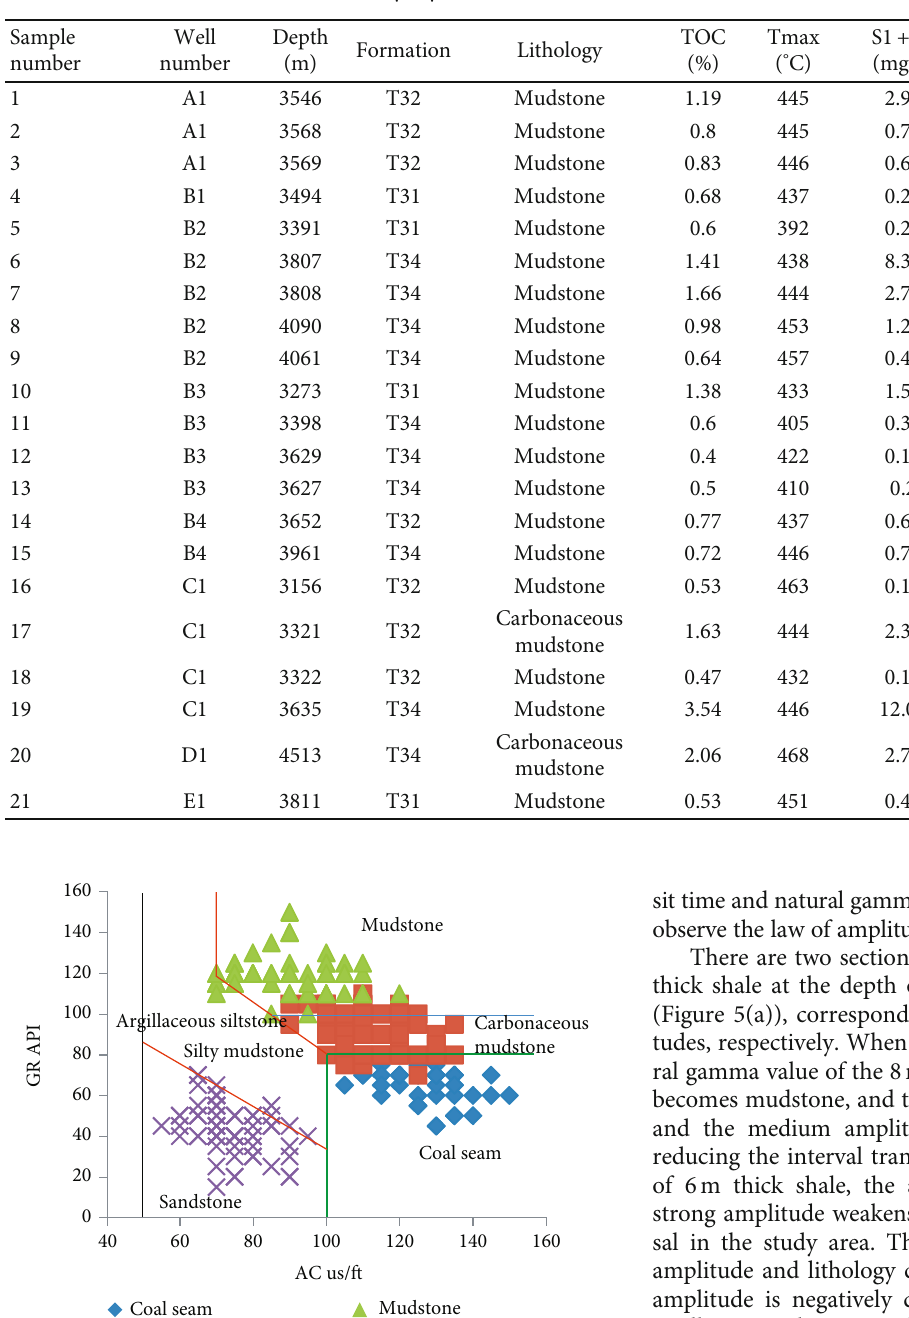
Table 1: Pyrolysis results of carbonaceous mudstone and dark mudstone.